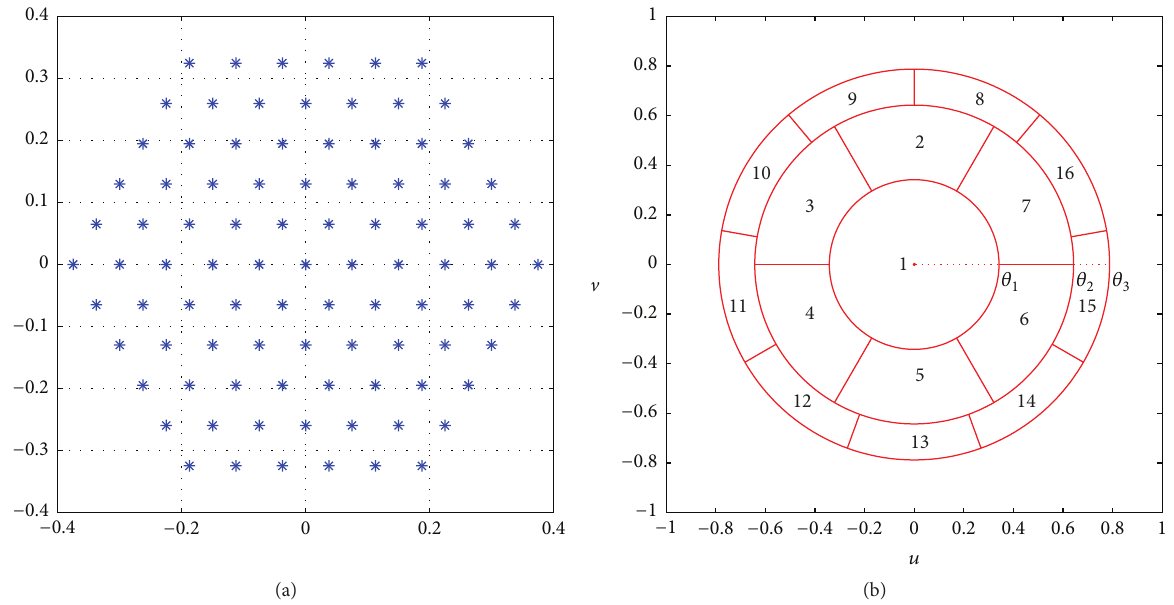
Figure 5: Array arrangement and pattern coverage regions. (a) The arrangement of the 91-element array and (b) the coverage regions of 16 different patterns.